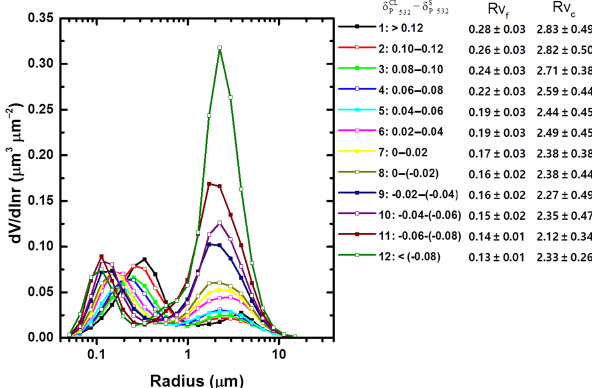
and δ CL at 532nm P P